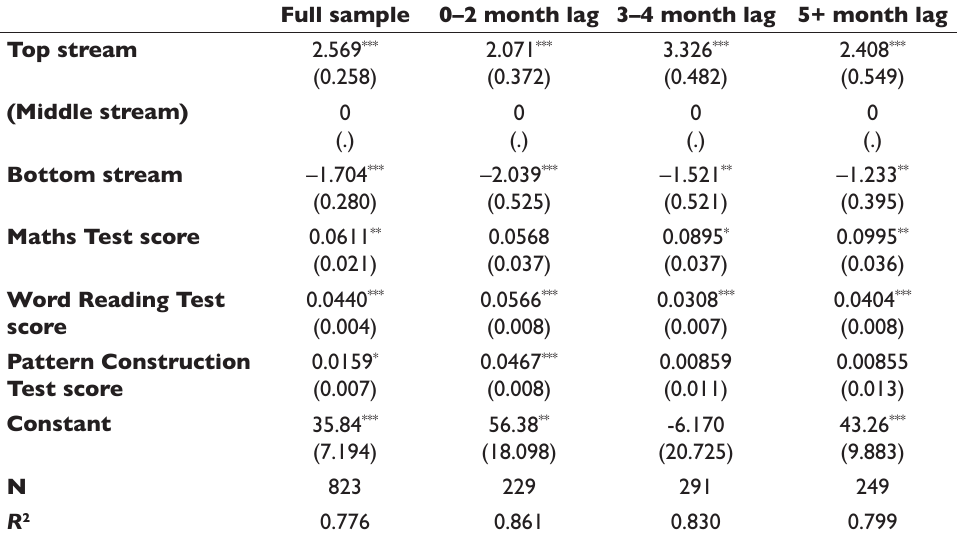
Table 7: Difference in summed survey-reported teacher judgement of ‘ability and attainment’ according to pupils’ stream placement: subgroups for cognitive test – teacher survey lag (a)(b) Full